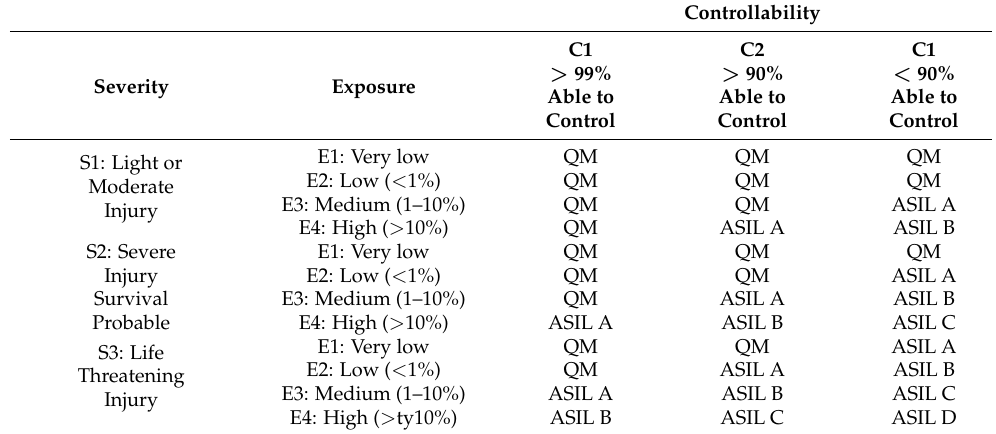
Table 4. ASIL determination